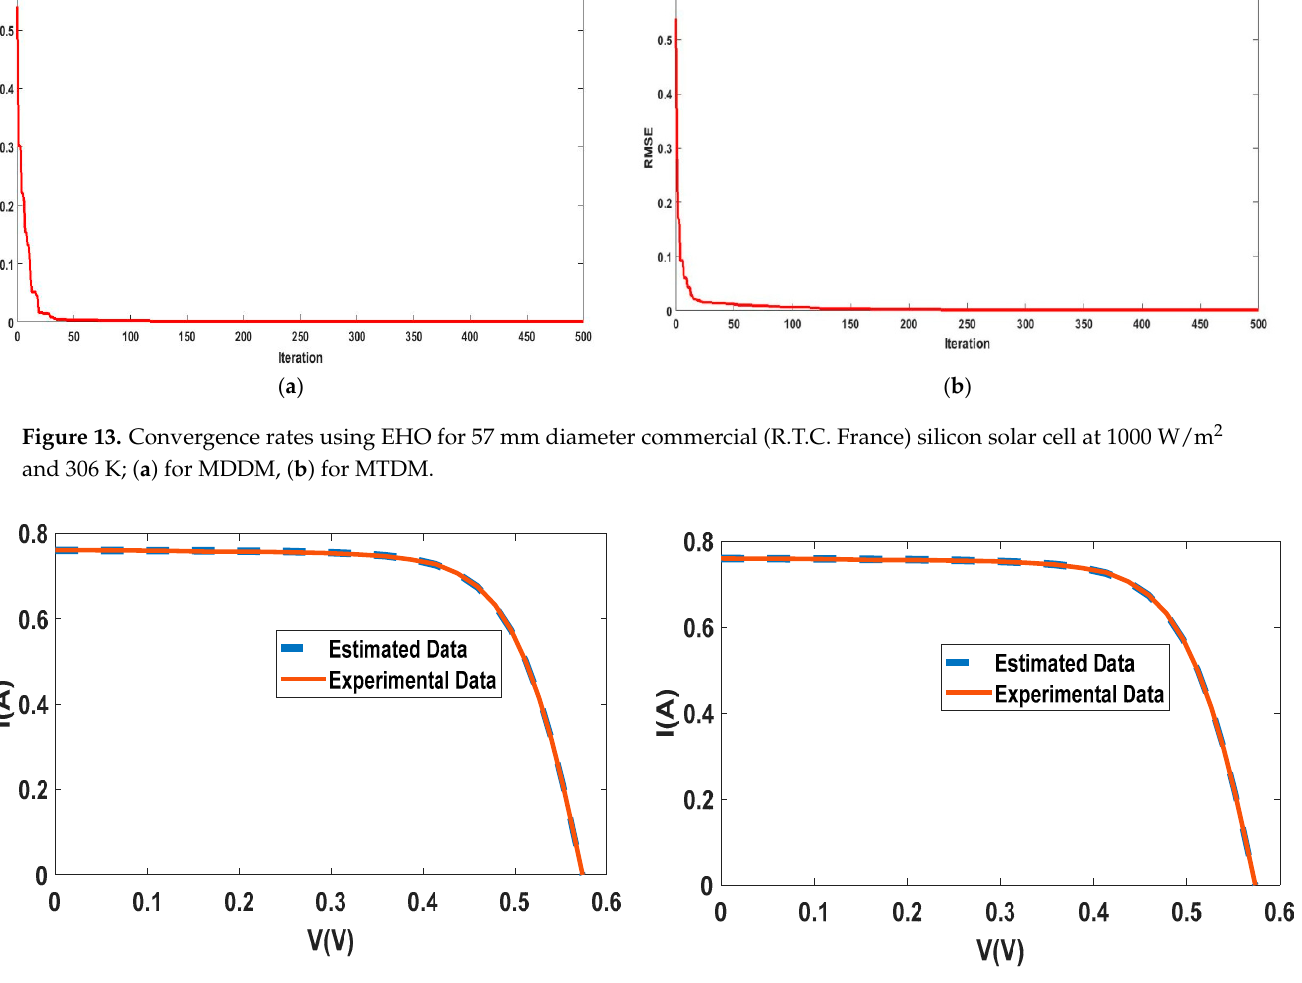
Figure 14. Estimated V-I versus experimental V-I using EHO for 57 mm diameter commercial (R.T.C. France) silicon solar cell at 1000 W/m 2 and 306 K; ( a ) for MDDM, ( b ) for MTDM.